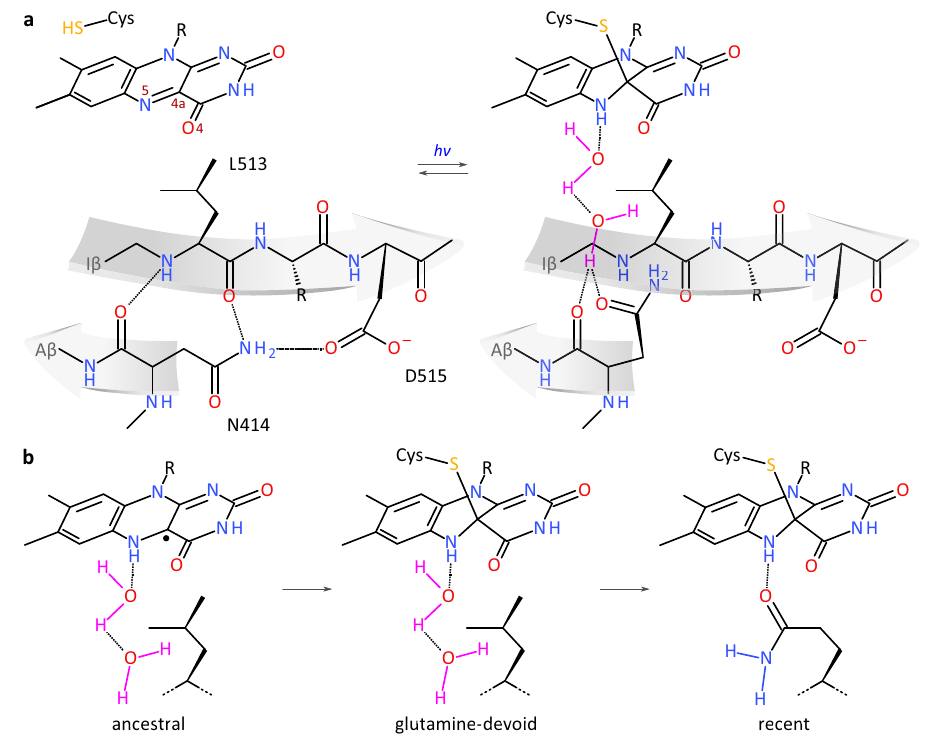
Fig. 7 Signal transduction in light-oxygen-voltage (LOV) receptors lacking the conserved glutamine, exempli fi ed for the A. sativa phototropin 1 LOV2 domain. a Lewis formulae show the fl avin- nucleotide chromophore and surrounding residues of the glutamine-de fi cient leucine variant in the dark-adapted (left) and light-adapted states (right). As revealed by X-ray crystallography (see Fig. 5), qualitatively similar structural responses to light-induced N5 protonation (see Fig. 1) are observed in both the absence of the conserved glutamine Q513 and in its presence (see Suppl. Fig. 15). Without the glutamine, water molecules might transiently enter the chromophore-binding pocket, thereby stand-in for the glutamine, and relay the signal as changes in hydrogen bonding to the I β and A β strands of the central β pleated sheet (involving residues N414 and 513). Notably, signals are thus also propagated to the LOV C terminus (D515) which is frequently engaged in signal transduction, and often exhibits a conserved DIT motif 6 . b The observation that LOV receptors can transduce signals without either or both of their strongly conserved cysteine and glutamine residues suggests a potential origin from redox-active fl avoproteins 14 . LOV signal transduction in a primordial LOV ancestor lacking the Cys and Gln residues would have relied on fl avin photoreduction to the NSQ radical and on water mediation. Both the Cys and Gln residues would be secondary acquisitions that minimize side reactions (Cys); enhance the fi delity of signal transduction (Cys and Gln); bathochromically shift the action spectrum (Gln); accelerate the dark recovery and thereby bene fi t temporal resolution (Cys and Gln); and render the signaling state less susceptible to the cellular environment (Cys). Note that we have no evidence in which sequential order the Gln and Cys residues may have been